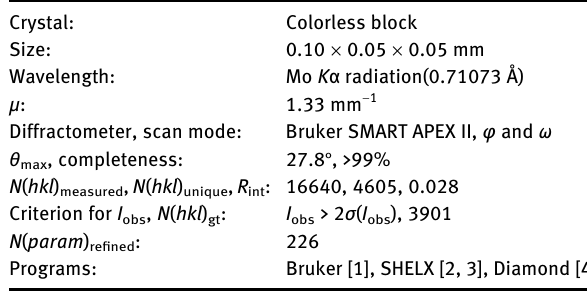
Table 1 contains crystallographic data and Table 2 contains the list of the atoms including atomic coordinates and displacement parameters.